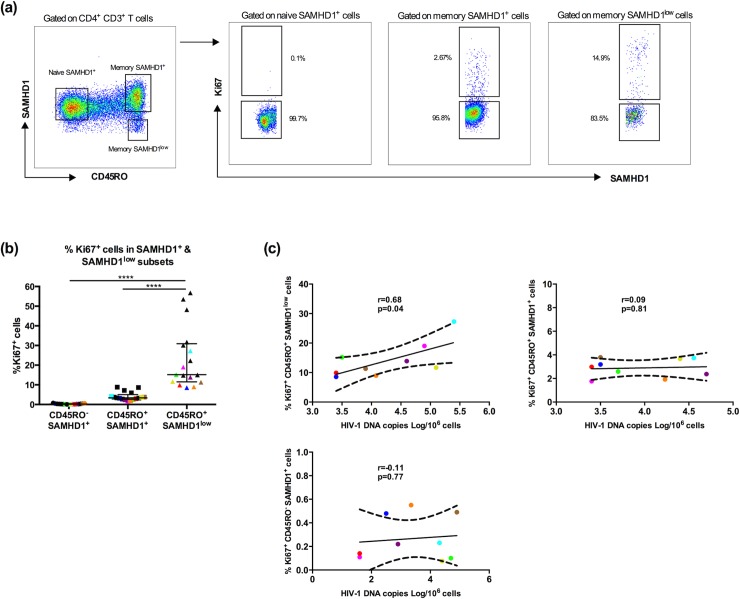
Total HIV-1 DNA levels positively correlate with Ki67 expression in memory SAMHD1low cells.Frozen PBMCs from HIV-1 infected individuals receiving c-ART (cART+ HIV-1+, n = 17) were stained with a cocktail of fluorochrome-conjugated -CD3, -CD4, -CD45RO, and -SAMHD1 monoclonal antibodies. A viability staining was used to exclude dead cells. (a) Gating strategy for Ki67- cells among naïve SAMHD1+ (CD45RO- SAMHD1+), memory SAMHD1+ (CD45RO+SAMHD1+) and memory SAMHD1low (CD45RO+SAMHD1low) compartments. (b) Percentages of Ki67+ cells amongst SAMHD1+ and SAMHD1low CD4+ T cells. Colored symbols represent the nine patients shown in (c). (c) Correlations between HIV-1 DNA levels and Ki67 expression of naïve SAMHD1+ (CD45RO- SAMHD1+), memory SAMHD1+ (CD45RO+SAMHD1+) and memory SAMHD1low (CD45RO+SAMHD1low) cells (n = 9 patients). Data represent median with interquartile range and ****p<0.001, t-test and 2-way ANOVA tests followed by Bonferroni post-tests and Spearman correlation.